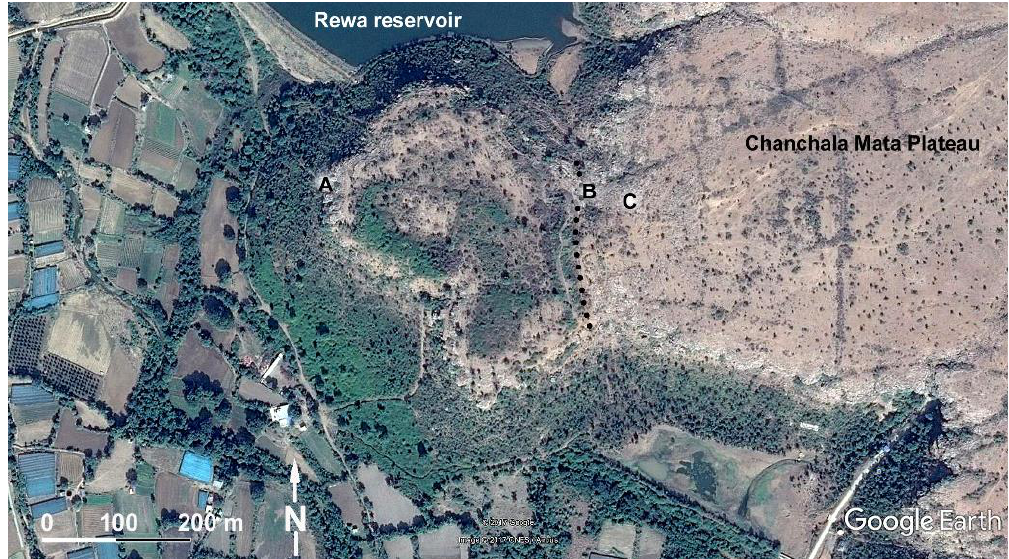
Figure 1. Satellite view of Indragarh Hill, showing the locations of Daraki-Chattan Cave (A) and the KEM sampling site (B). The 240 m long paleo-channel is shown by a dotted line. Most of the hill’s plateau is covered by the ruins of a fort. In the northernmost part of the paleo-channel, the original bedrock has been fully exposed by this erosion process, revealing a site of former rapids leading to a small waterfall at a location where the main-channel is joined by a tributary from the east. The usually cream-colored quartzite bedrock at this location has been subjected to intensive battering by the fully rounded cobbles and small boulders swept through the paleo-channel. This bedload of purple-colored quartzite debris remains preserved in the lowest conglomerate layer. At the paleo-rapids, the channel’s thalweg forms a chute allowing maximum acceleration and release of kinetic energy as the bedload became suspended. All surfaces affected by this prolonged bombardment have developed KEM laminae. However, not all of these panels have survived, because where the protective tectonite has been breached, weathering eroded the substrate and caused widespread exfoliation of the intact hardened surface. Some of the laminae are still concealed by the superimposed coarse conglomerate. The KEM lamina can even be detected on hundreds of cobbles and small boulders exposed in this lowest-most conglomerate (Figure 2).